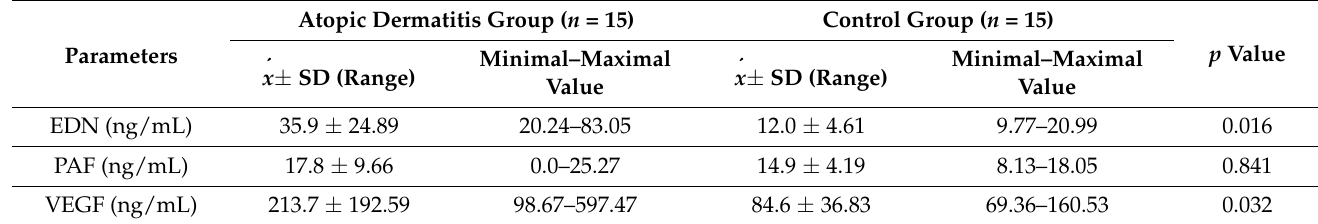
Figure 1. The mean serum concentrations of the examined molecules in patients with atopic dermatitis (AD) and healthy control. Table 2. Laboratory findings in examined participants.